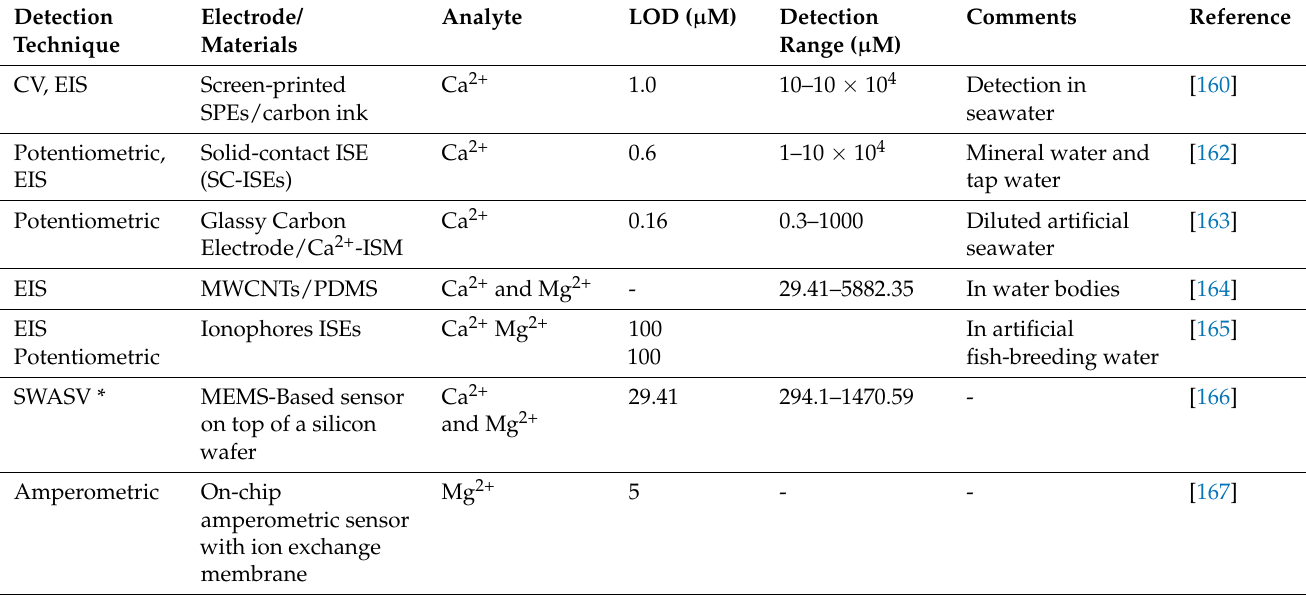
Table 4. Overview of electrochemical sensors for water hardness ions in water.